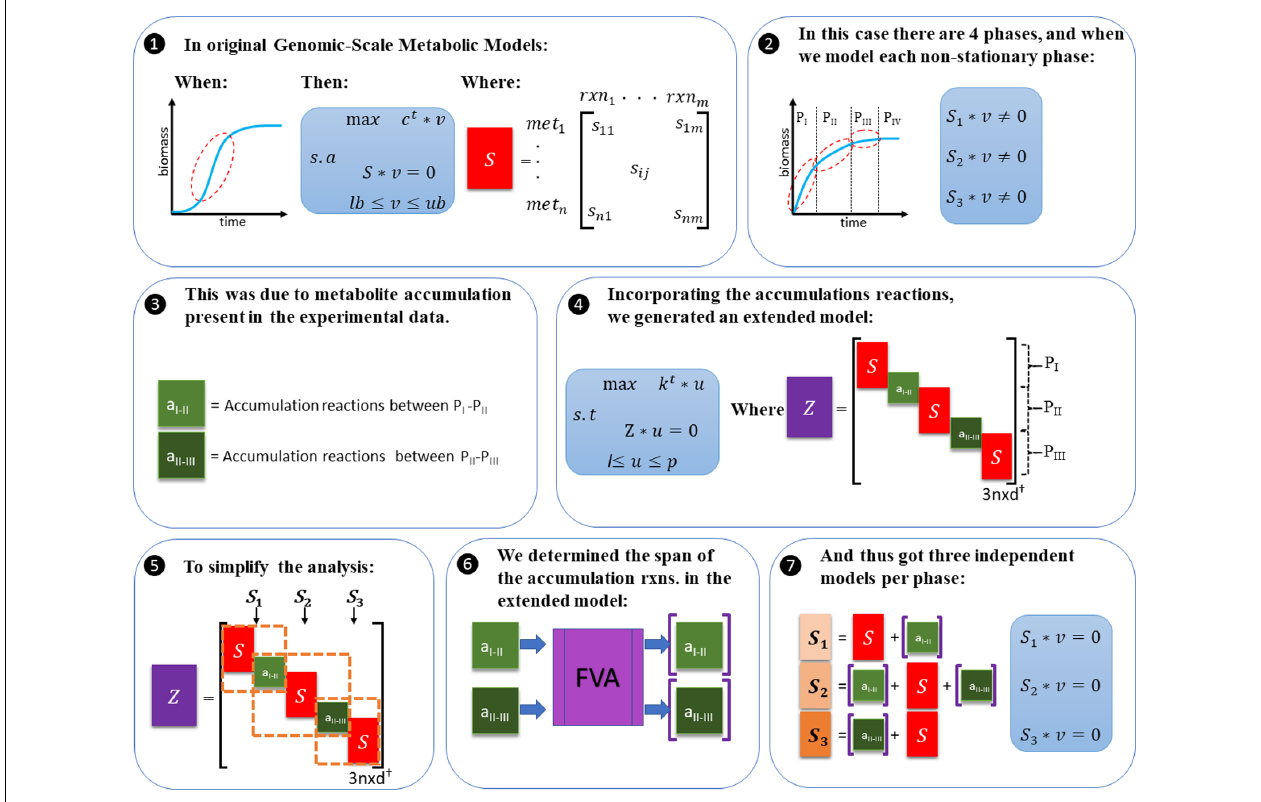
FIGURE 1 | Framework for the incorporation of the experimental data. (1) General approach used to model exponential phase in GEMS. (2) Our experimental results showed four phases: three growth phases and a fourth phase, corresponding to stationary phase. Growth phases couldn’t be modeled individually as there was accumulation, as observed in the experimental results. (3) These accumulation compounds were: malate and mannitol, and the amino acids valine, phenylalanine, cysteine and threonine. Accumulation was observed between phases I to II, and II to III, and not from III to IV. (4) The extended model was constructed, which was able to simulate simultaneously the three phases identified for each ethanol level, and the accumulation observed experimentally. This matrix includes the following components: a matrix “Z” that contains three “S” matrix, one per phase, and 2 “a” vectors (1 × 6), where “a” represents the accumulation reactions that allows interaction between phases; thus, matrix sigma has a size (3n × d), where d = 3m + 2 ∗ 6. The extended model also includes vector “u” (1 × d) of internal fluxes, limited by vector “l” and “p” (1 × d), and a vector “k” of weights (1 × 3n). (5) To simplify the analysis, the extended matrix can be divided into three independent problems, one corresponding to each phase, and thus each one includes an S matrix, and a set of accumulation reactions as input of the system (accumulation in the previous phase) and/or output of the system (accumulation in the consecutive phase). (6) The span of these accumulation reactions was determined with flux variability analysis in the extended model, with the experimental data fixed in the model. (7) Estimations and further calculations were carried out in the independent model described in (5), with the span determined in (6) for the accumulation